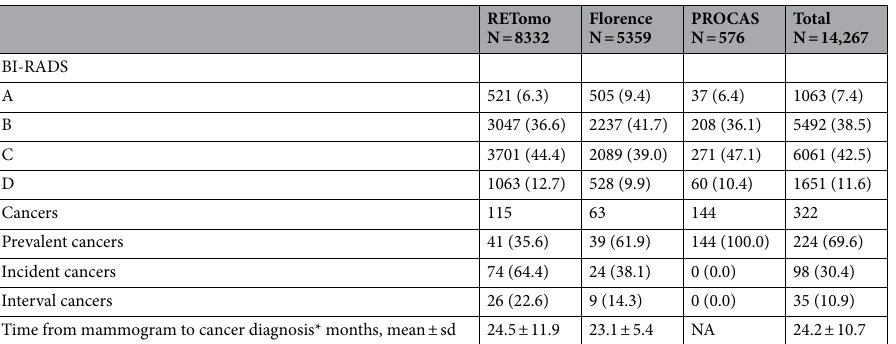
Table 1. Distribution of cancer types and breast density categories among women by study centre. *Only for incident